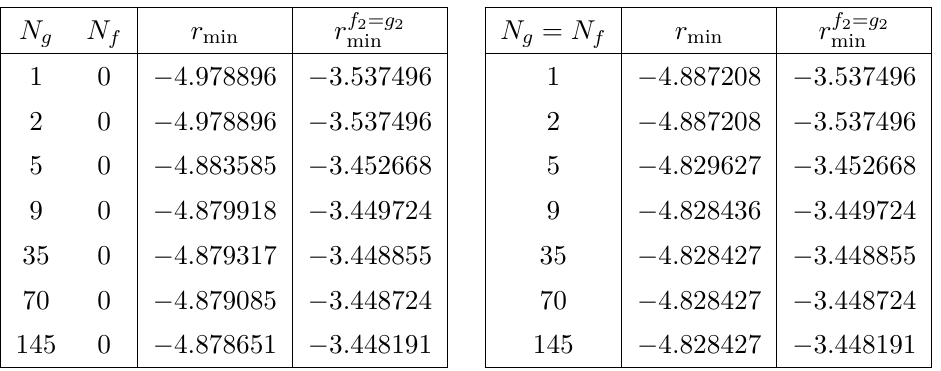
Table 1 . Lower bounds g 3 /g 2 > r min /M 2 using a number N g ( N f ) of g -type ( f -type) null